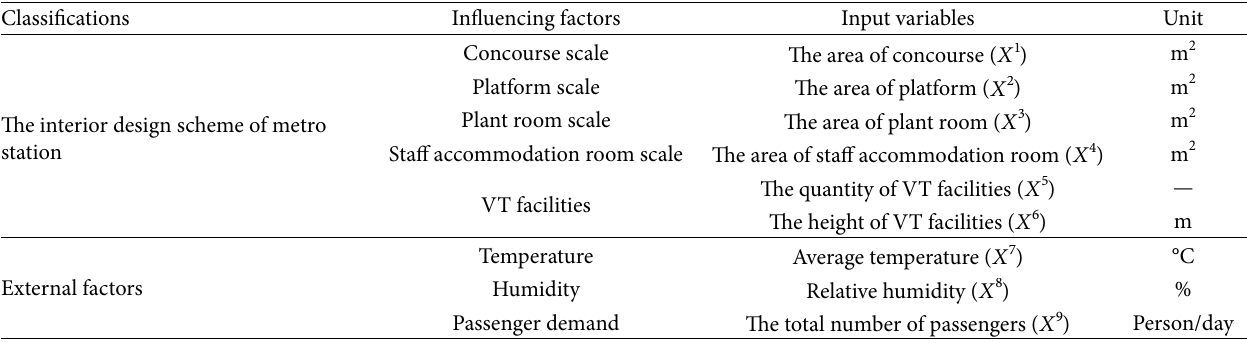
Table 1: Summary of input